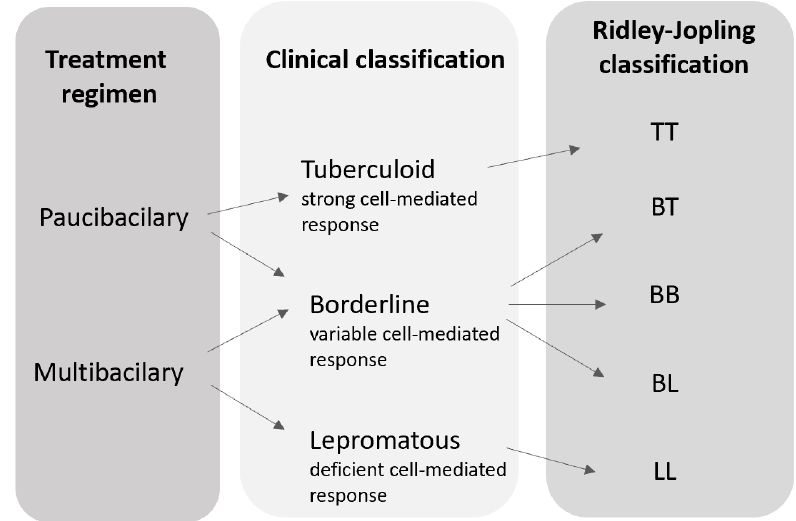
Figure 2. Schematic illustration of leprosy classification.